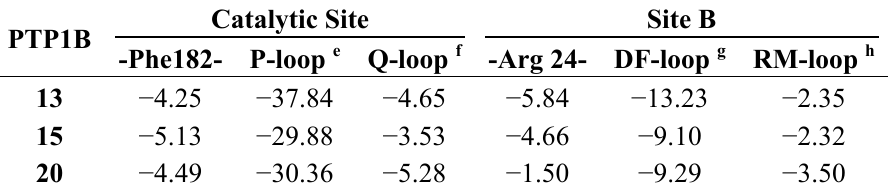
Table 4. The key residues of the PTP1B binding energy during the simulation (kcal/mol).